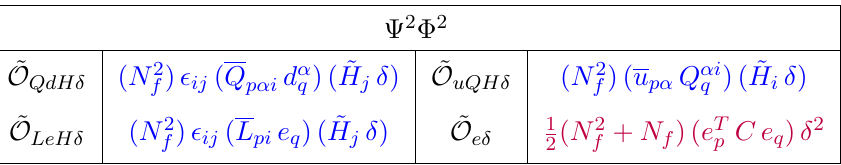
Table 2 . Additional IR DOFs (Color Singlets) as representations of the SM gauge groups along with their spin quantum numbers.